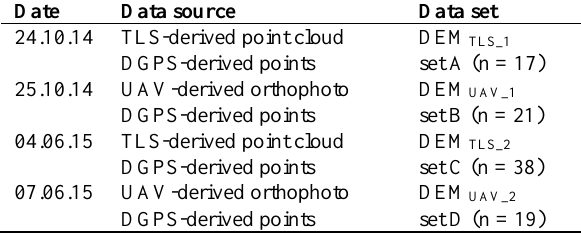
Table 1. Acquired data sets.